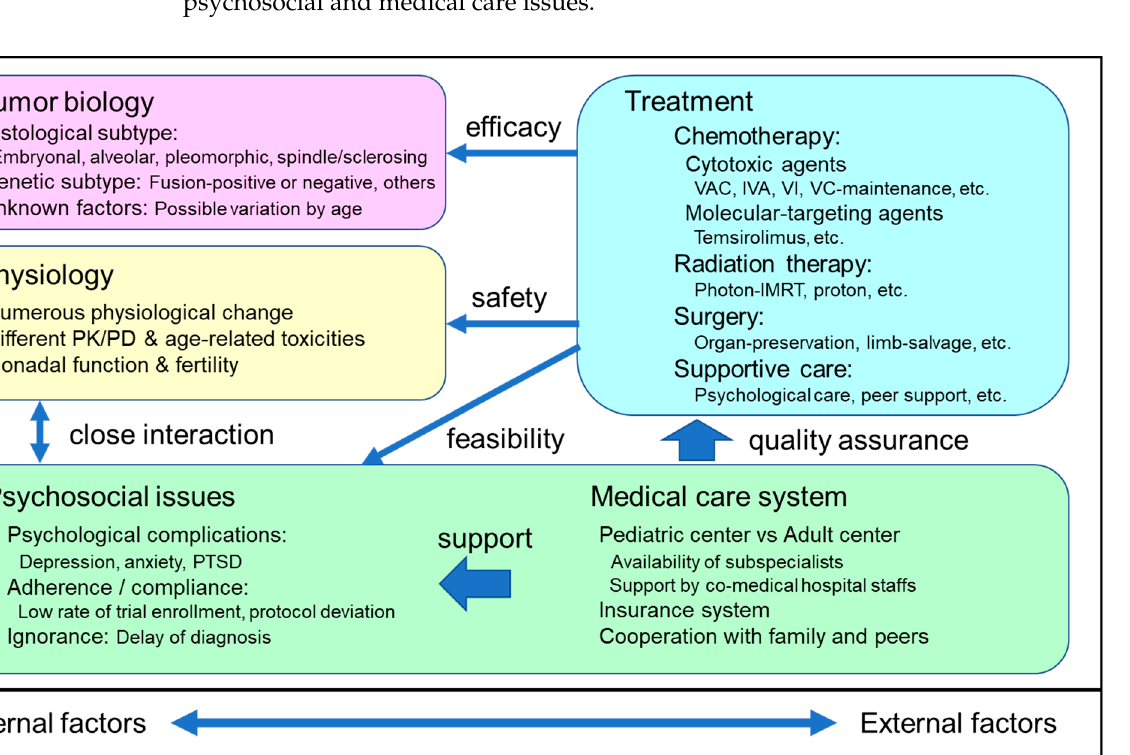
Figure 1. Major factors influencing the poor outcomes in AYA RMS. The reason for the poor RMS outcomes in AYA patients is multifactorial. The factors significantly influencing poor outcomes include internal factors, external factors, and a combination of various issues. The impact of each factor will be discussed in the following chapters. IMRT, intensity-modulated photon radiotherapy;